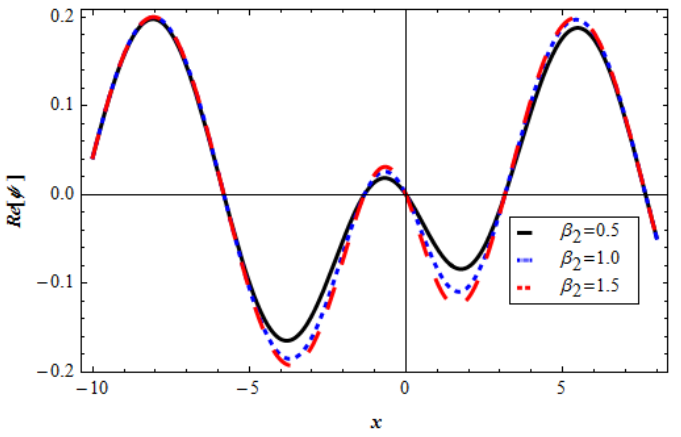
Figure 10. Change of solution (20) with z , t , β 2 for c = 0.5, v = 0.7, β 1 = 0.1, β 3 = 0, β 4 =